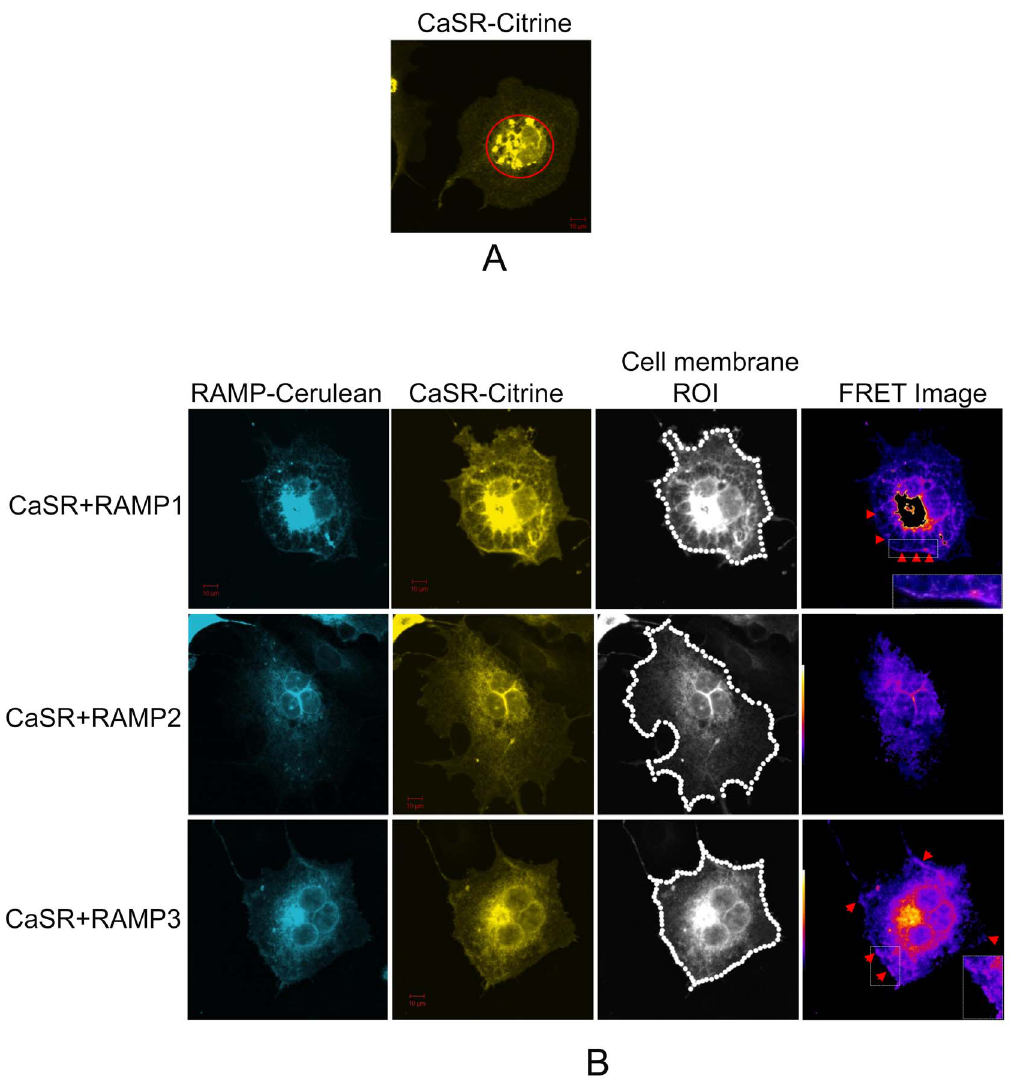
Figure 1. Spatial localization of CaSR and RAMPs in COS-7 cells. (A) COS-7 cell transfected with CaSR-citrine alone showing intracellular localisation of CaSR (red circle) in the absence of RAMP expression. (B) COS-7 cells co-transfected with RAMP-cerulean (left column) and CaSR-citrine (column 2) were imaged by confocal microscopy 48 hr post transfection. 50 pixel dot ROI was manually drawn around the cell membrane of the CaSR-citrine image to measure cell-surface FRET (column 3). Scale bar 10 m m. Red arrows on the FRET images (right column) indicate areas of co- localization between CaSR and RAMP on the cell-surface, which are shown magnified in the insets.